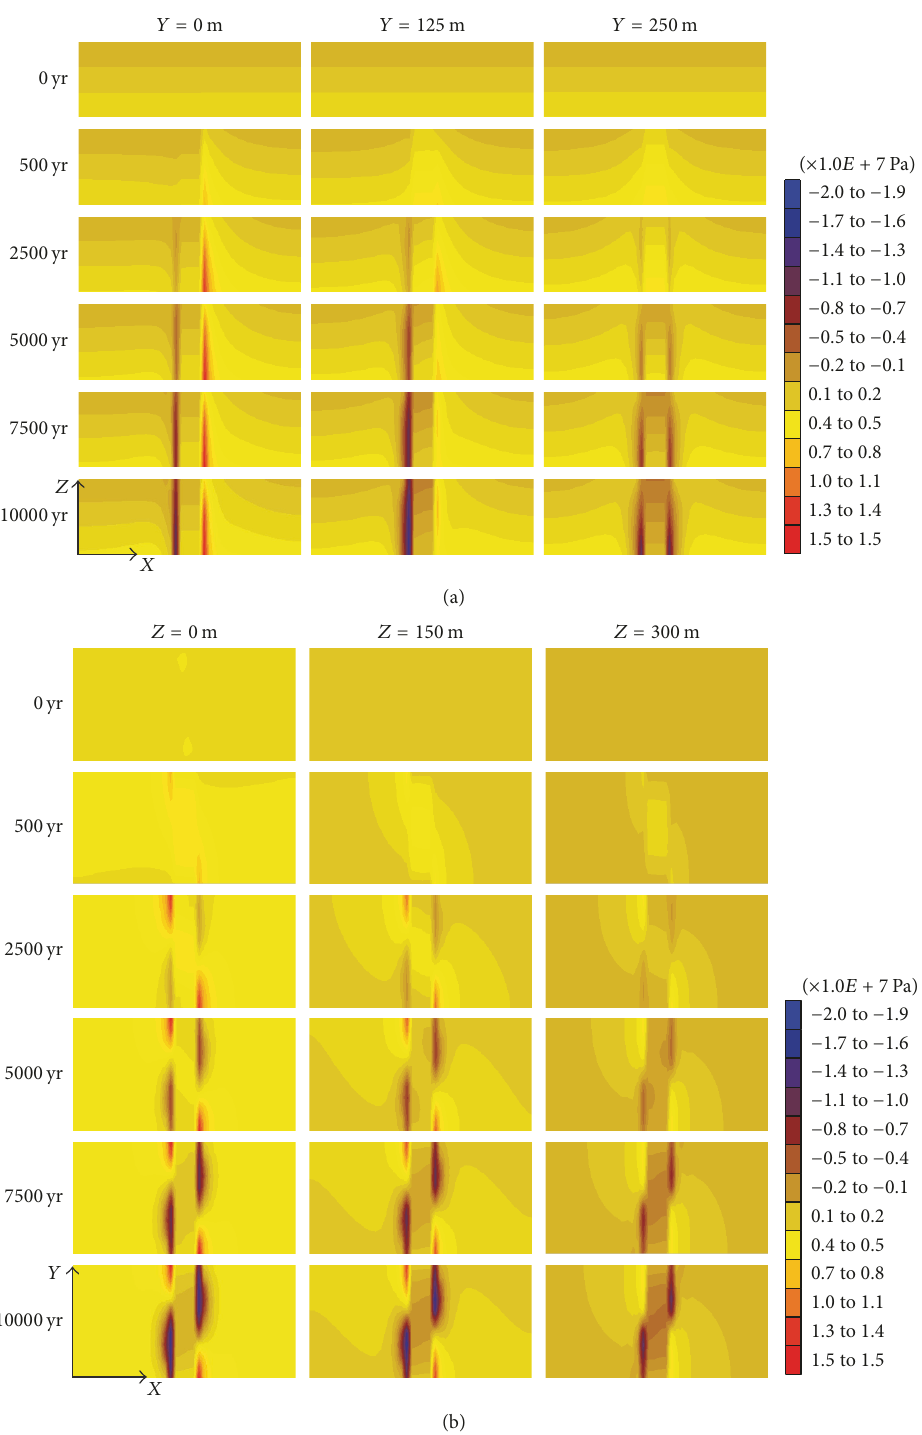
Figure 6: Contour map of the pore pressure ( 𝑃 ) for Model II at different times. (a) is three vertical cross sections of 𝑌 = 0 , 125 m, and 250 m; (b) is three horizontal cross sections of 𝑍 = 0 , 150m, and 300